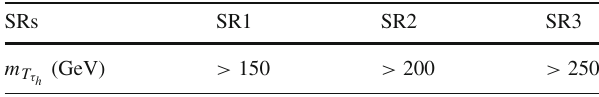
Table 3 Three signal regions are defined by the values of m T τ